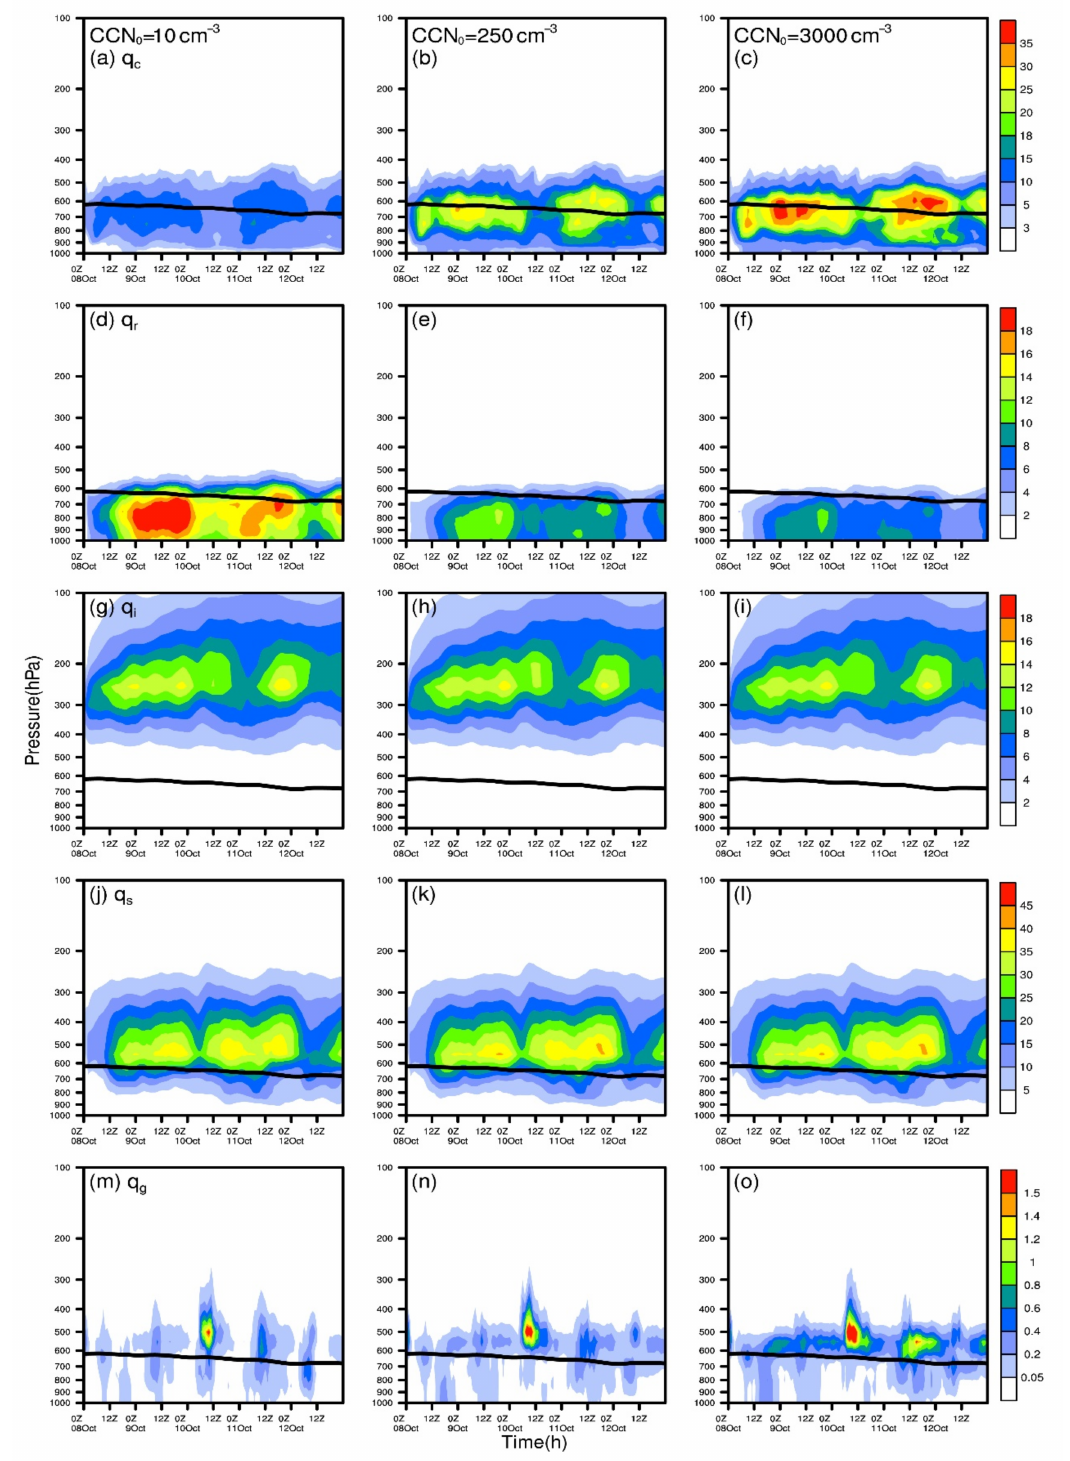
Figure 2. Temporal changing of vertical profiles of area-averaged q c ( a – c ), q r ( d – f ), q i ( g – i ), q s ( j – l ), q g ( m – o ) (mg/kg) from 8 to 12 October (left: CCN 0 = 10 cm − 3 , mid: CCN 0 = 250 cm − 3 , right: CCN 0 = 3000 cm − 3 ). The solid black line represents the 0 ◦ C